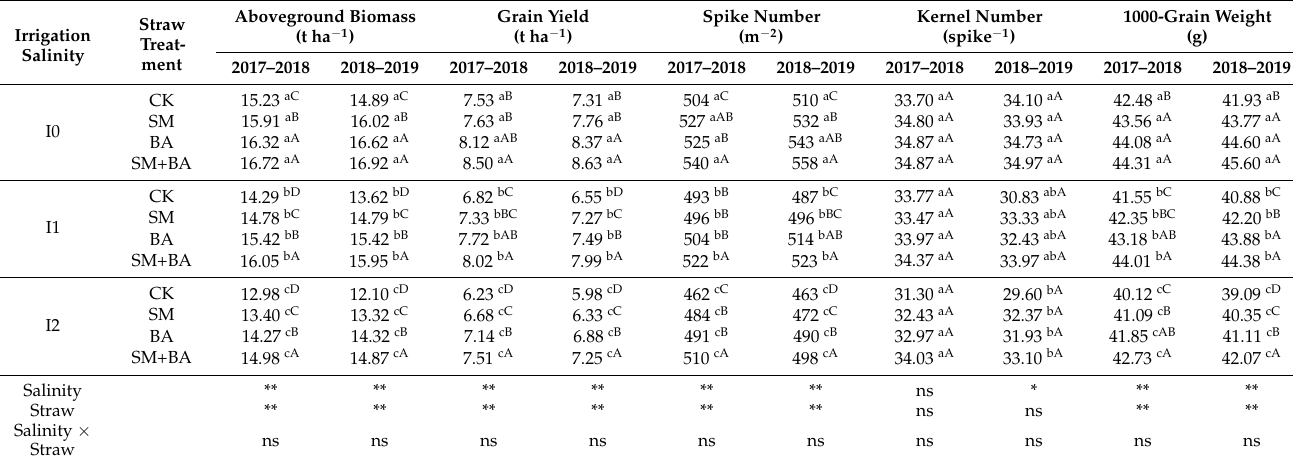
Table 3. Mean values of the winter wheat grain yield parameters, including the aboveground biomass, grain yield, spike number, kernel number, and 1000-grain weight for the different straw-returning modes and irrigation water salinity in 2017–2018 and